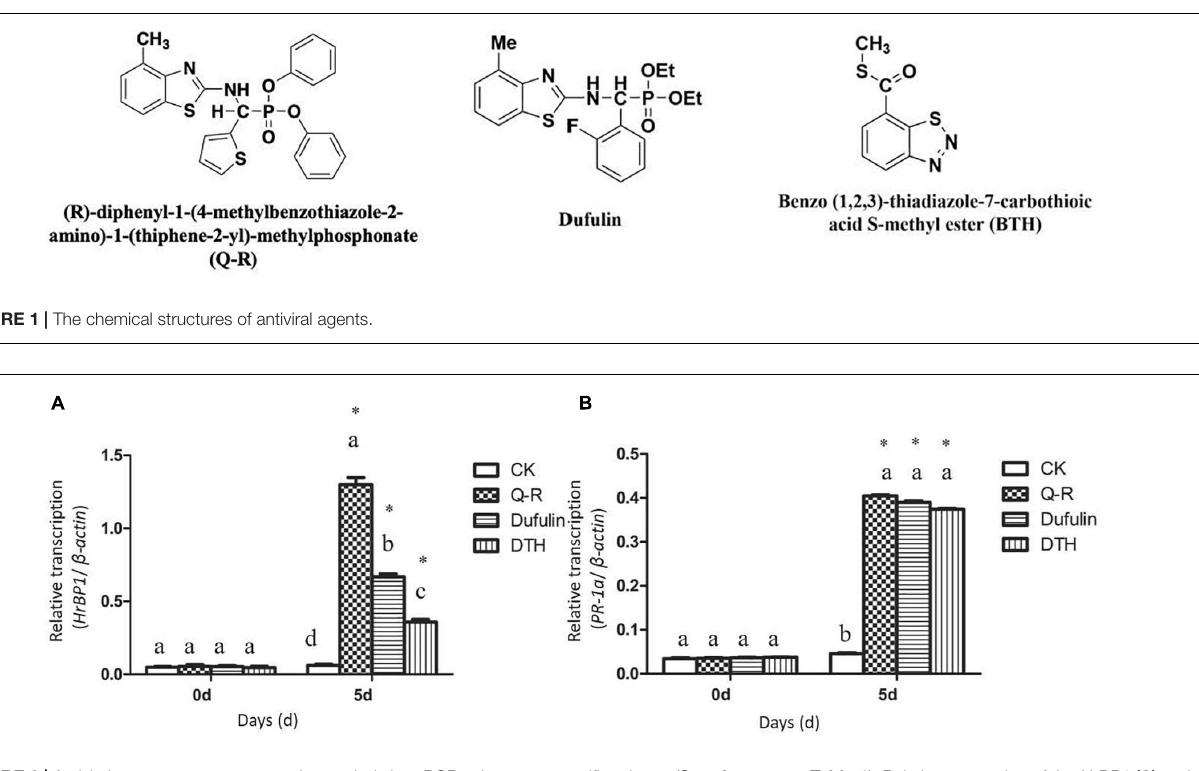
FIGURE 2 | Antiviral response genes expression analysis by qPCR using gene-specific primers ( Supplementary Table 1 ). Relative expression of the HrBP1 (A) and PR-1a (B) genes in TMV-infection plants treated with Q-R, dufulin and BTH at 500 µ g/mL at 5 days. Asterisks represent the significantly different between agent treatment and control ( P < 0.05). The different lowercase letters represent HrBP1 / PR-1a genes expression values in the different treatment groups ( P < 0.05).